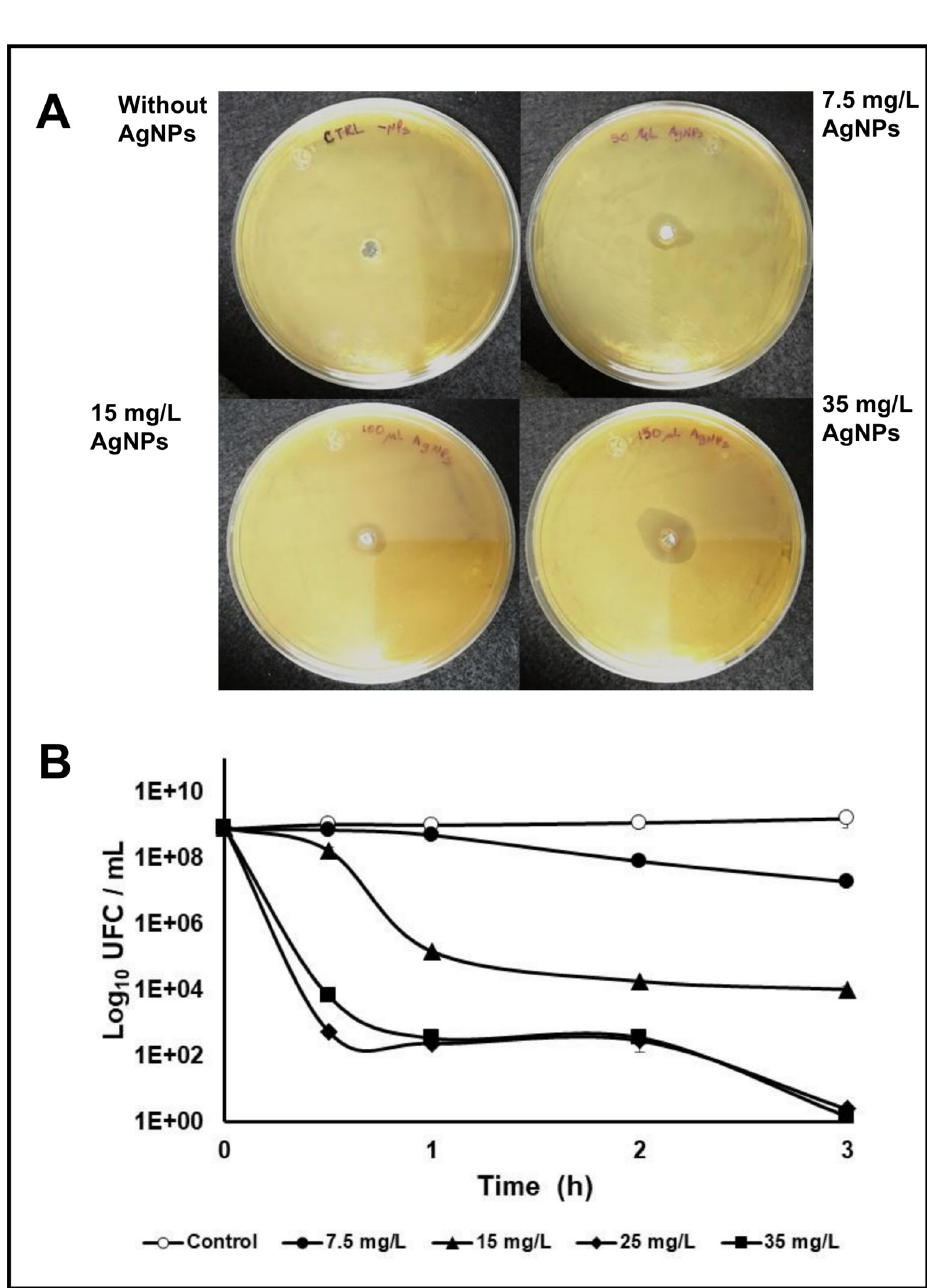
Fig 9. Antibacterial effect of fungal biosynthesized AgNPs over the planktonic cells of uropathogenic E . coli (UPEC). (A) Diffusion agar plates that show the growth-inhibition zones produced by the exposition of UPEC-PAM5 cells to increasing concentrations of AgNPs. (B) Cell viability in UPEC-PAM5 bacterial suspensions at different times of treatment with increasing concentrations of fungal-biosynthesized AgNPs. Viability without addition of AgNPs was used as control